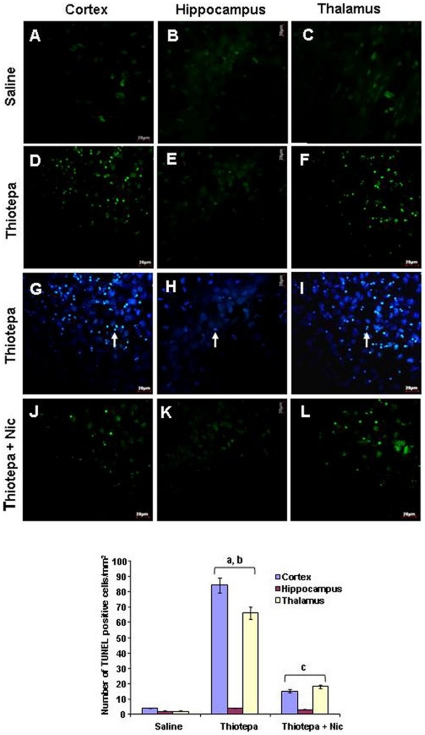
Co-treatment effect of nicotinamide on thiotepa-induced apoptotic neurodegeneration.Representative photomicrographs of TUNEL staining show apoptotic dead neuronal cells after thiotepa administration with nicotinamide. The arrows indicate thiotepa-induced TUNEL stained apoptotic dead neurons (D and F) counterstained with DAPI (G and I) in the cortex and thalamus. Nicotinamide treatment effectively blocked thiotepa-induced apoptosis, as evident from the lack of TUNEL-positive cells (J and L). Images are representative of staining obtained in sections (3–5/group) prepared from at least 5–6 animals/group. (A–L) of TUNEL-stained brain tissue at higher magnification with 40× objective field, Scale bar = 20 µm. Statistical difference was determined using one-way analysis of variance (ANOVA) followed by Student's t-test. (aSignificantly different from CTL, [cortex P<0.001 and thalamus P<0.001]; bSignificantly different from Thiotepa + Nicotinamide, [cortex P<0.01 and thalamus P<0.01]; cSignificantly different from Thiotepa, [cortex P<0.01 and thalamus P<0.01]).